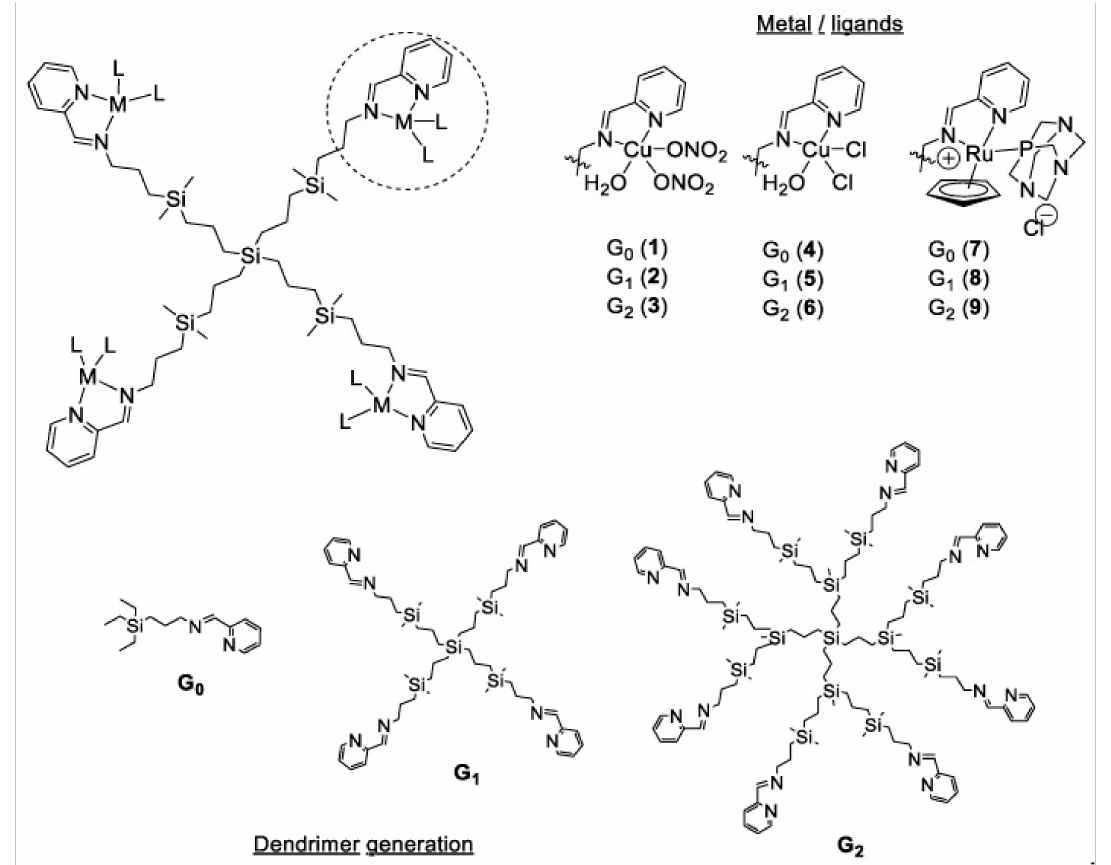
Figure 5. Chemical structure of carbosilane metallodendrimers